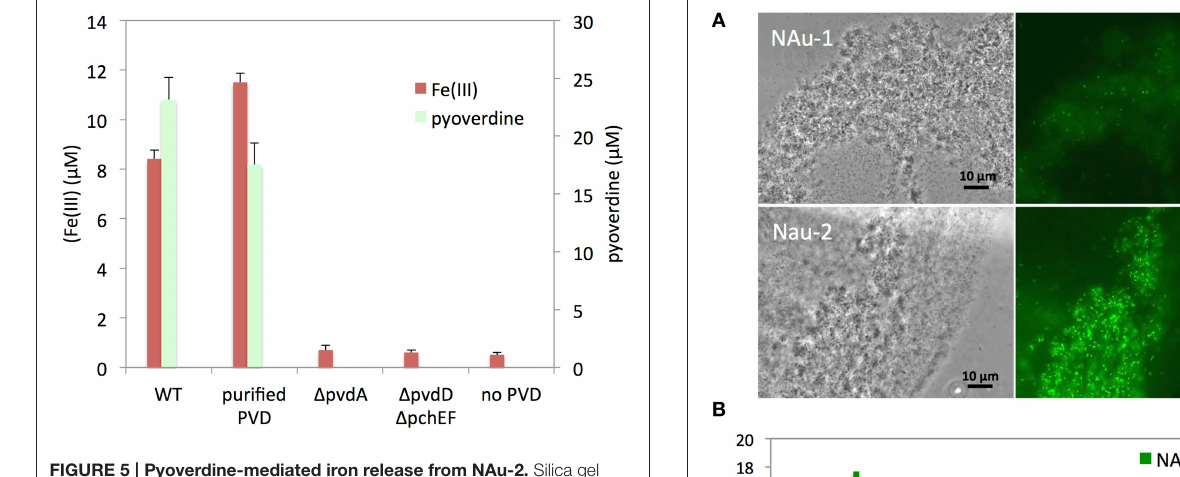
FIGURE 5 | Pyoverdine-mediated iron release from NAu-2. Silica gel embedded NAu-2 particles were incubated with or without purified pyoverdine (PVD) and with cell-free culture supernatants of PAO1 WT, PAO1 1 pvdA or PAO1 1 pvdD 1 pchEF strains grown in DCAA medium. Pyoverdine and iron concentrations were determined after 24 h of incubation. Errors bars represent the standard error of the mean ( n = 3).